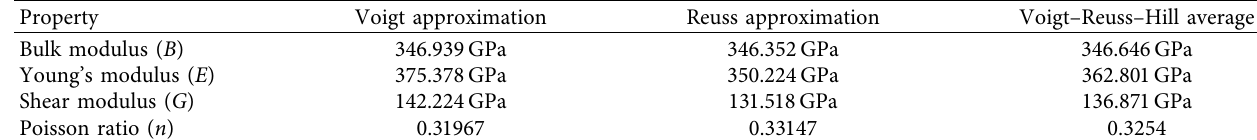
Table 3: Bulk, shear, and Young’s modulus, and the Poisson ratio of EuFe